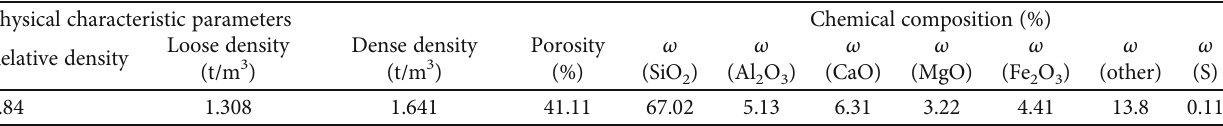
Table 1: Physical and chemical properties of total